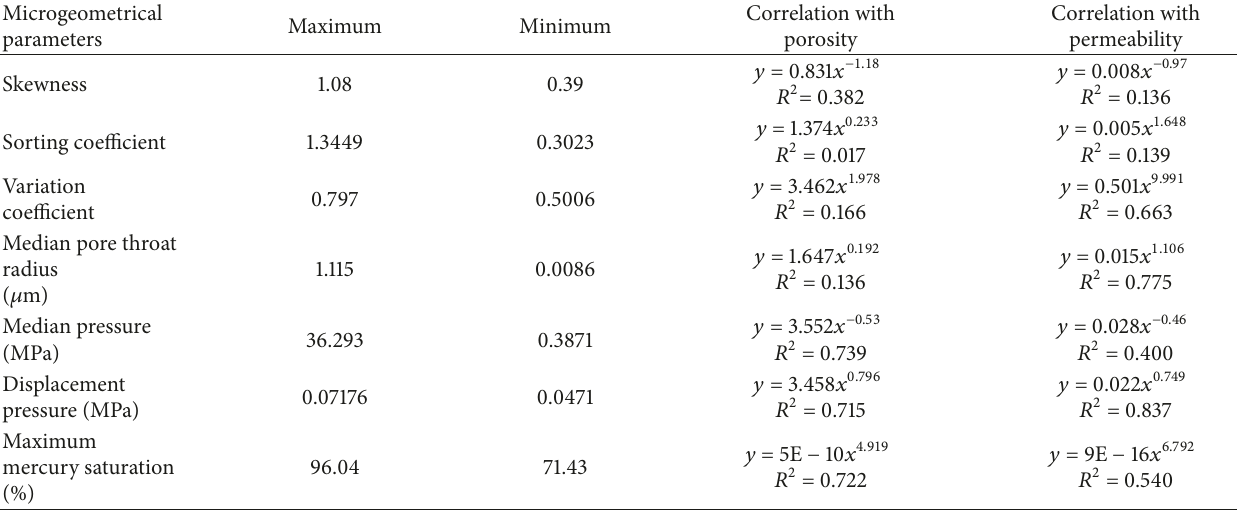
Table 6: Relationship of throat microgeometrical parameters with porosity and permeability.